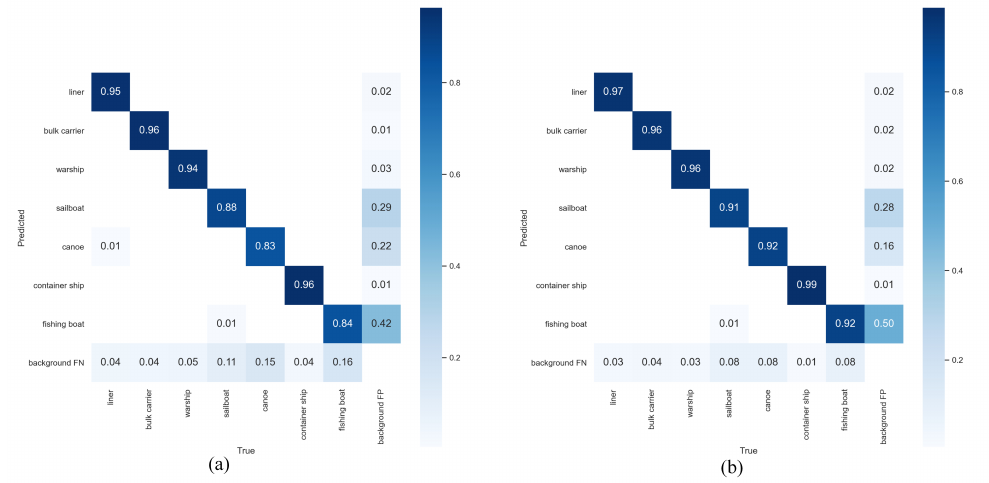
Figure 14. Confusion matrices. ( a ) YOLOv5; ( b ) CAA-YOLO.